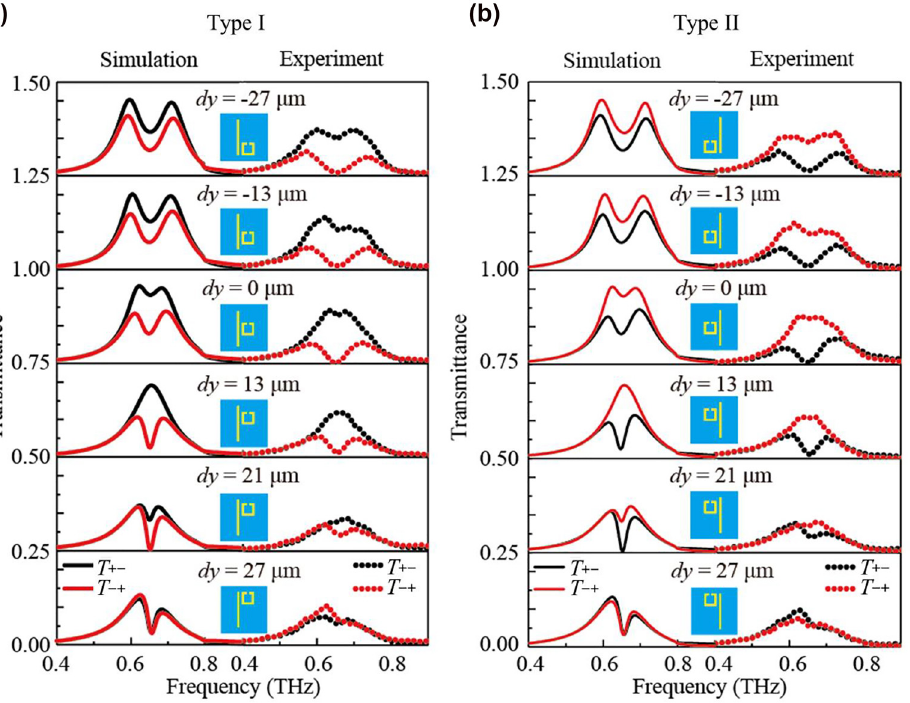
Figure 3: The simulated (solid lines) and experimental (dotted lines) spectra of the metasurfaces for (a) type-I and (b) type-II with varying dy . The black and red lines represent the transmittances of T +− and T −+ respectively. For clarification, each spectrum is vertically shifted with 0.25 in